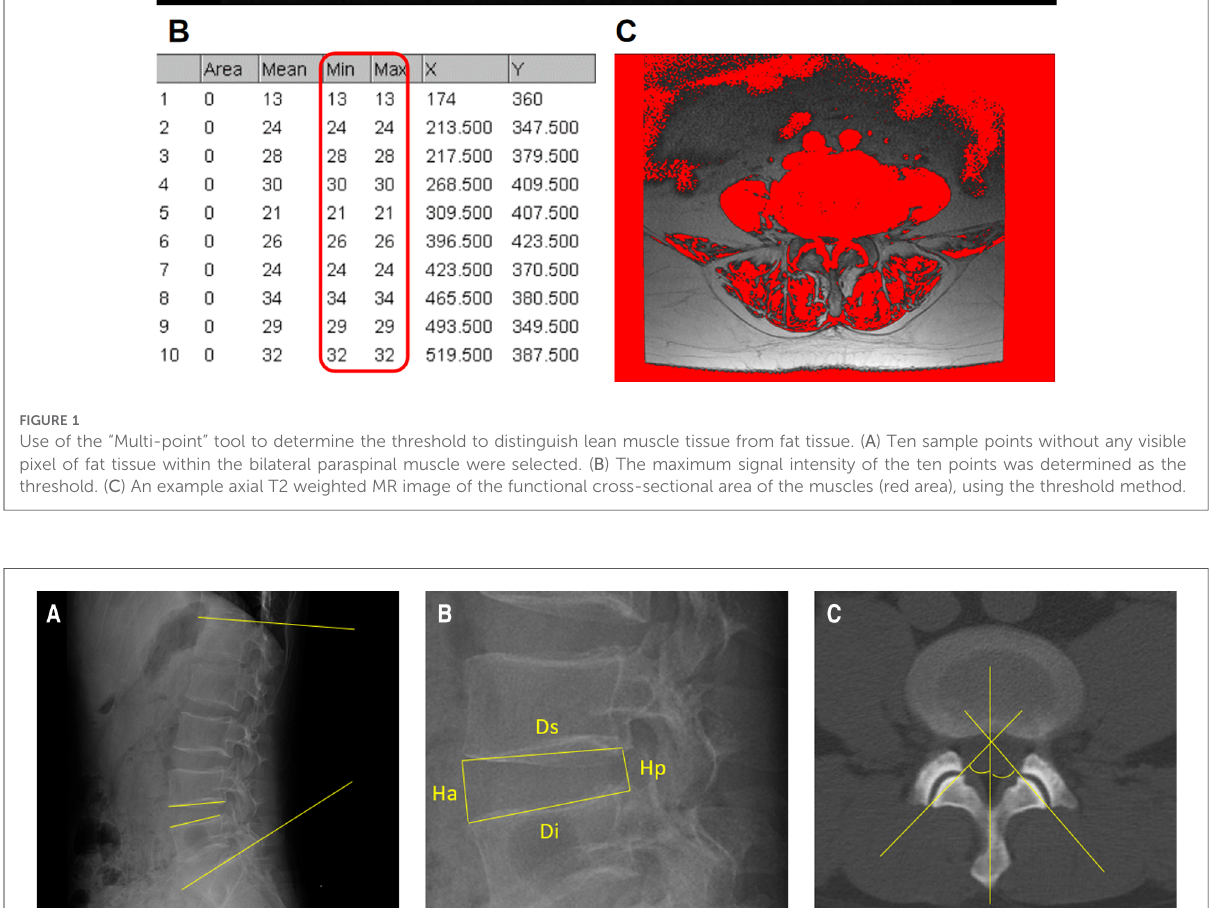
0.002), and a smaller SMI (849.7 mm 2 /m 2 vs. 1008.7 mm 2 /m 2 , p < 0.001). There were no signi fi cant differences in other radiological characteristics between the two groups ( p > 0.05).